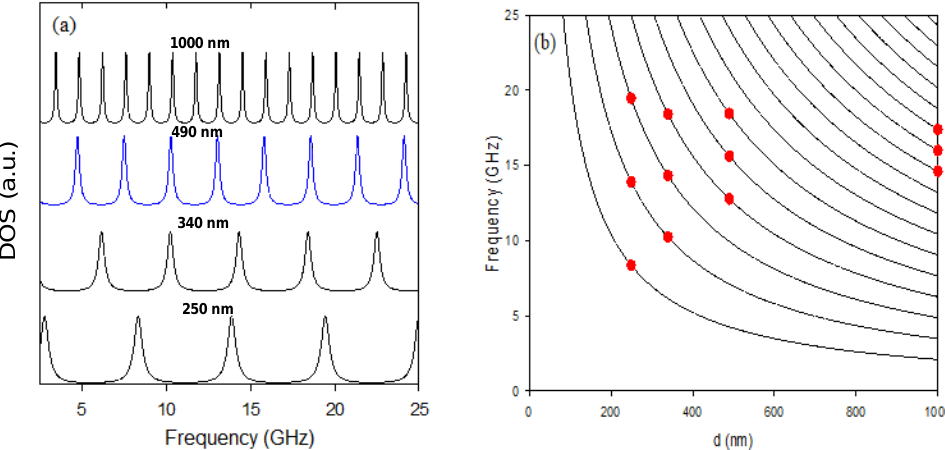
Figure 4. ( a ) Variation of density of states (in arbitrary units) of layer modes for the different layer thicknesses. ( b ) Quantified frequencies of layer modes as a function of layer thickness. Peak positions of experimental spectra are given as red circles around the frequency 16 GHz.